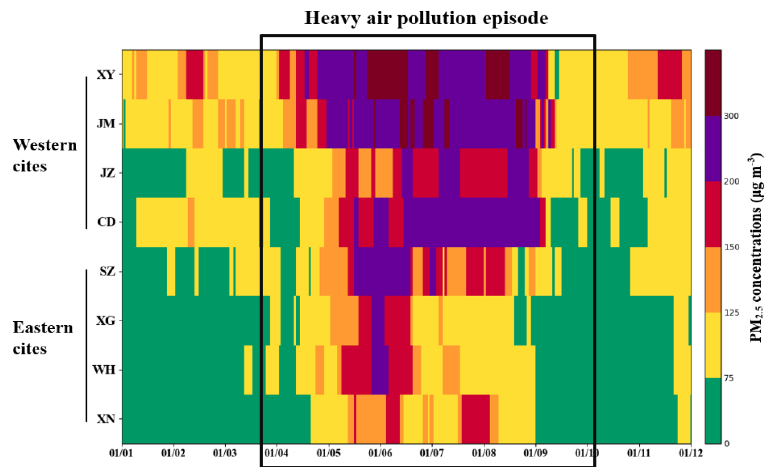
Figure 2. Hourly changes of PM 2.5 concentrations at 8 cities of XY, JM, JZ, CD, SZ, XG, WH, and XN (as shown in Figure 1), with the black frame indicating the heavy air pollution event over the THB.